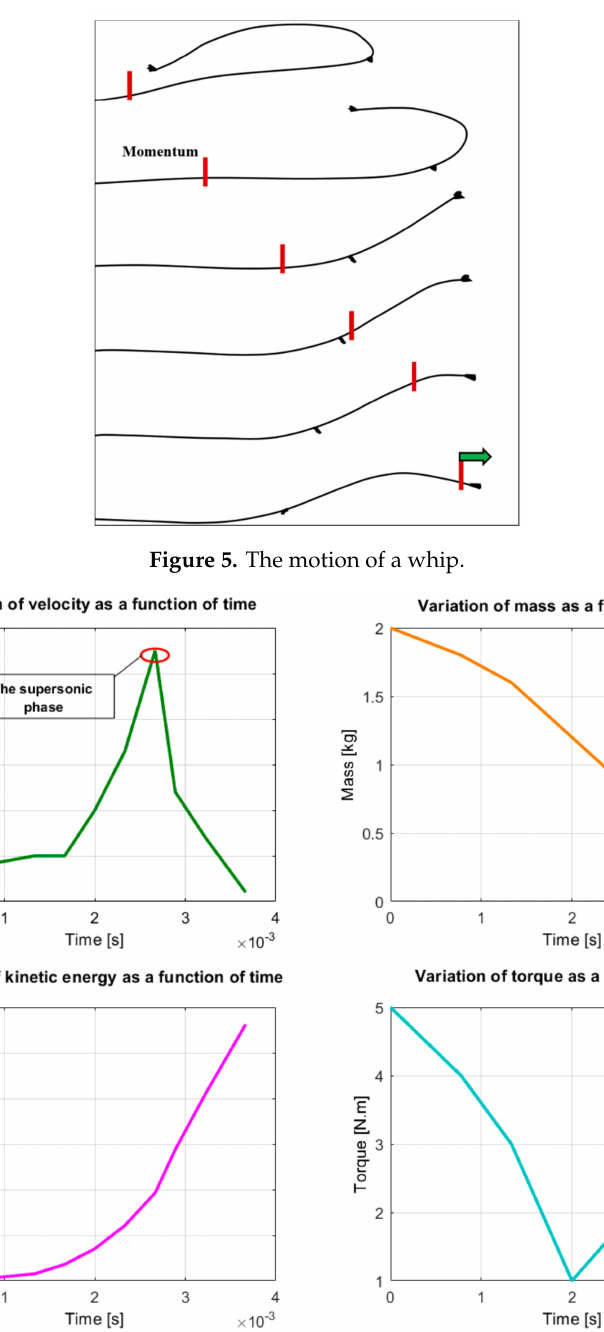
Figure 6. The variation of velocity, mass, kinetic energy, and torque as a function of